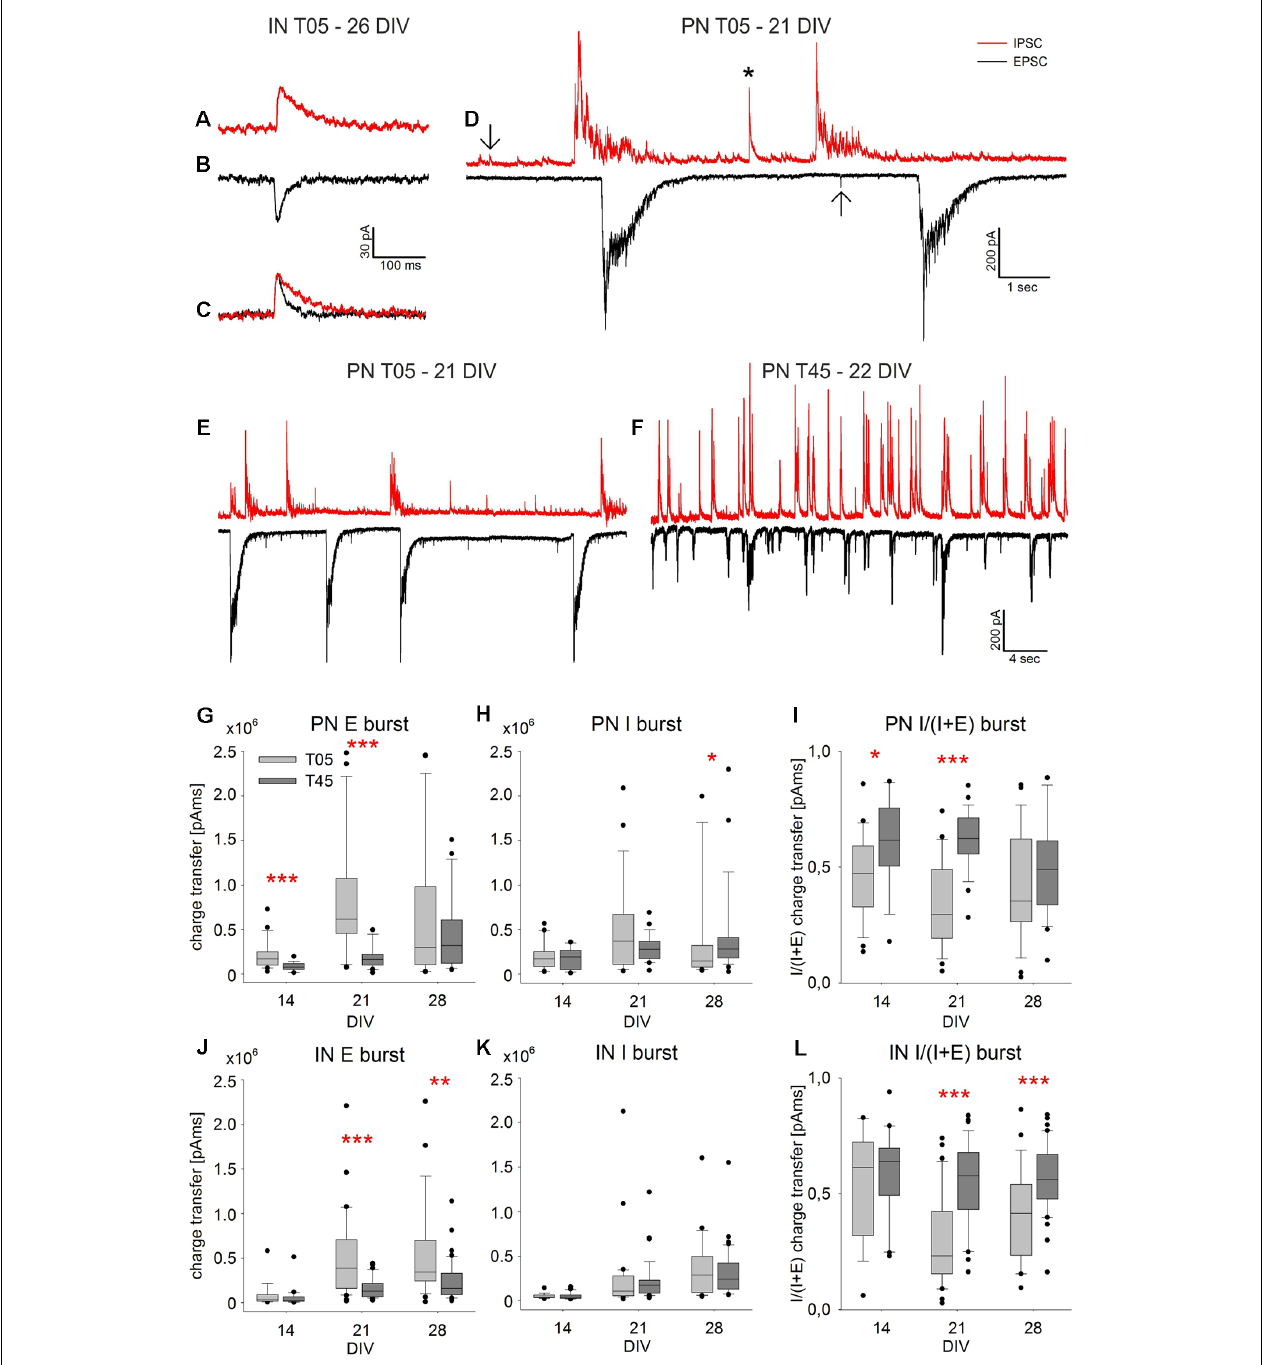
FIGURE 8 | Spontaneous PSC Bursts. The exemplary spontaneous IPSCs (A) and EPSCs (B) were recorded in an IN (T05, 26 DIV). The slower decay time of inhibitory currents is visualized by scaling the PSCs shown in (A,B) to the same amplitude (C) . The examples of single isolated PSCs ( D , arrows), a short multisynaptic event ( D , asterisk), and large network bursts (D) were recorded in a PN (T05, 21 DIV). While isolated PSCs are single synaptic events ( A–C , arrows in D ), network bursts of large amplitude (D) are elicited by a barrage of synaptic inputs over several 100 ms. Panels (E,F) show exemplary traces illustrating the difference between spontaneous burst currents in PNs of T05 ( E , 21 DIV) and T45 networks ( F , 22 DIV). The quantitative analysis of network burst charge transfer is shown in (G–L) . For both neuron types, EPSC burst charge transfer increased in the 3rd week, most prominently in T05 (G–J) , while the increase of IPSC burst charge transfer was less pronounced (H–K) . As a consequence, the burst charge transfer ratio [I/(I + E)] was lower in T05 compared with T45 networks (I,L) reflecting the lower synaptic inhibitory drive in both neuron types of T05 networks (see also: E,F ). Asterisks show the level of statistical significance of differences between network types (* P ≤ 0.05, ** P ≤ 0.01, *** P ≤ 0.001). For statistical significance of age differences, see text.